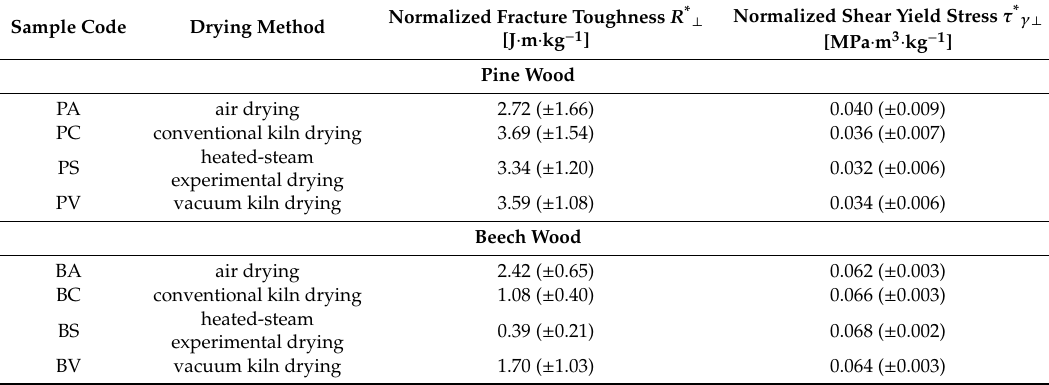
Table 3. Fracture toughness R * ⊥ and shear yield stress τ * γ ⊥ normalized by density (average value and standard deviations) for of Scots pine and beech dried with di ff erent Table 4. Significance of differences between fracture toughness and shear yield stress of pine and beech samples dried with different methods (ANOVA) ( α = 0.05).